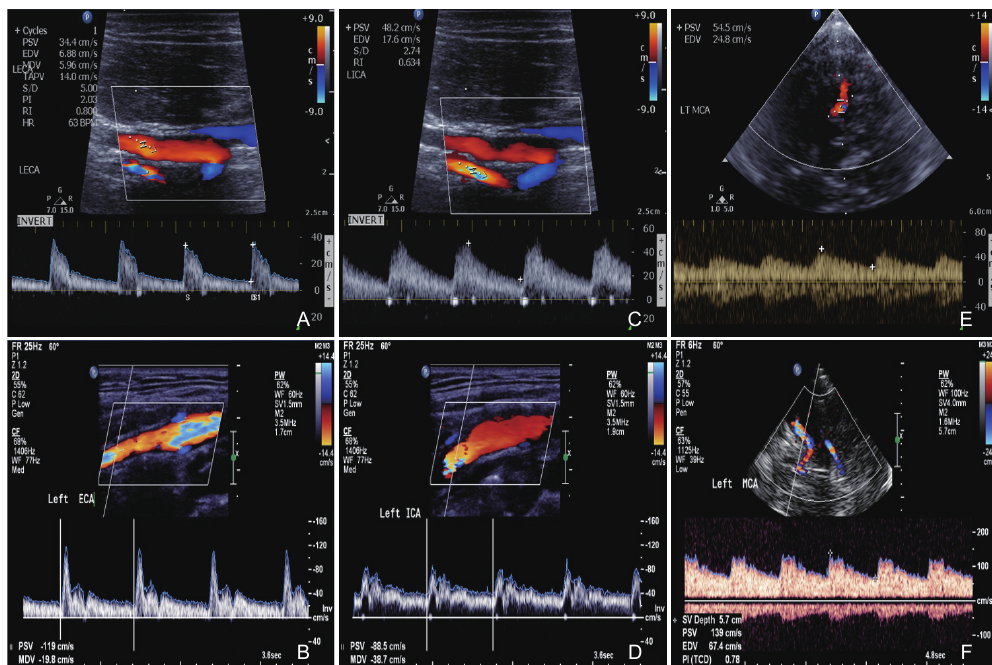
Figure 1 Hemodynamic comparison of carotid arteries and middle cerebral artery between human and rhesus monkeys. (A) The left ECA of rhesus monkeys was shown by ultrasound. The PSV was 34.4 cm/s, EDV was 6.88 cm/s, RI was 0.80. (B) The left ECA of human being was shown by ultrasound. The PSV was 119 cm/s, EDV was 19.8 cm/s. (C) The left ICA of rhesus monkeys was shown by ultrasound. The PSV was 48.2 cm/s, EDV was 17.6 cm/s, RI was 0.63. (D) The left ICA of human being was shown by ultrasound. The PSV was 88.5 cm/s, EDV was 38.7 cm/s. (E) The left MCA of rhesus monkeys was shown by TCCD. The PSV was 54.5 cm/s, EDV was 24.8 cm/s. (f) The left MCA of human being was shown by TCCD. The PSV was 139 cm/s, EDV was 67.4 cm/s, PI was 0.78.